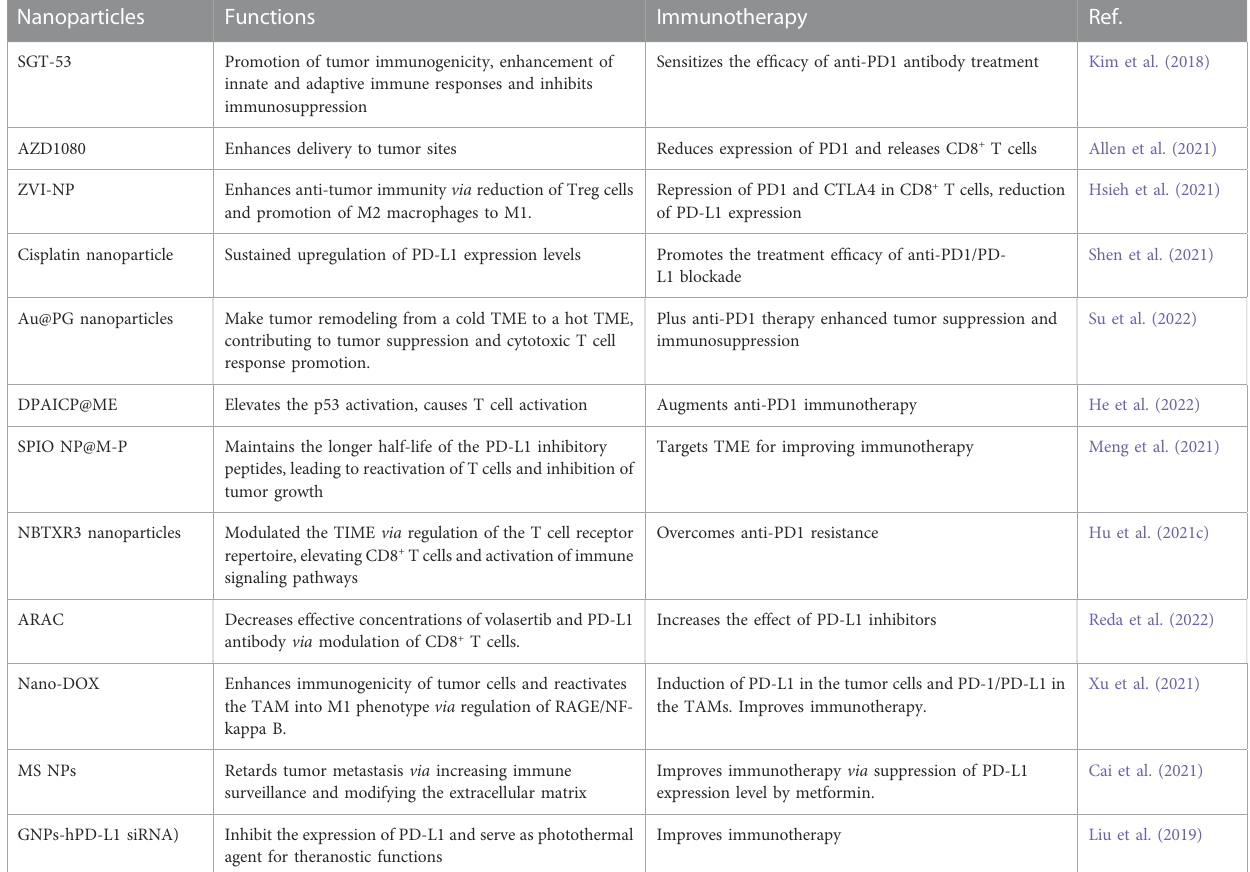
TABLE 1 Nanoparticles in regulation of TME and immunotherapy in lung